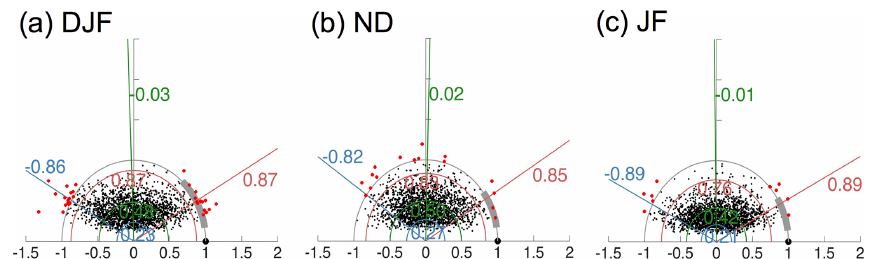
Figure A4. Taylor diagrams for permutation tests corresponding to the same events in Fig. A2 (1870–2014). The thick gray arc marks the 5th-to-95th percentile range in the corresponding panel in Fig. A2. Other features in the Taylor diagrams are as described in Fig. 2. See Appendix A for more details.